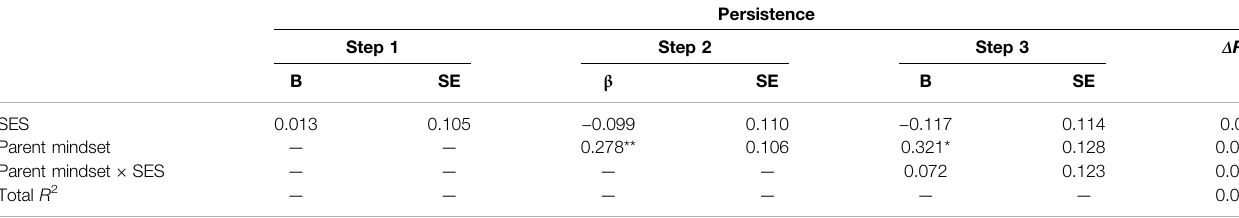
TABLE 5 | Results from regression models (research question 3 and 4 regarding Children ’ s